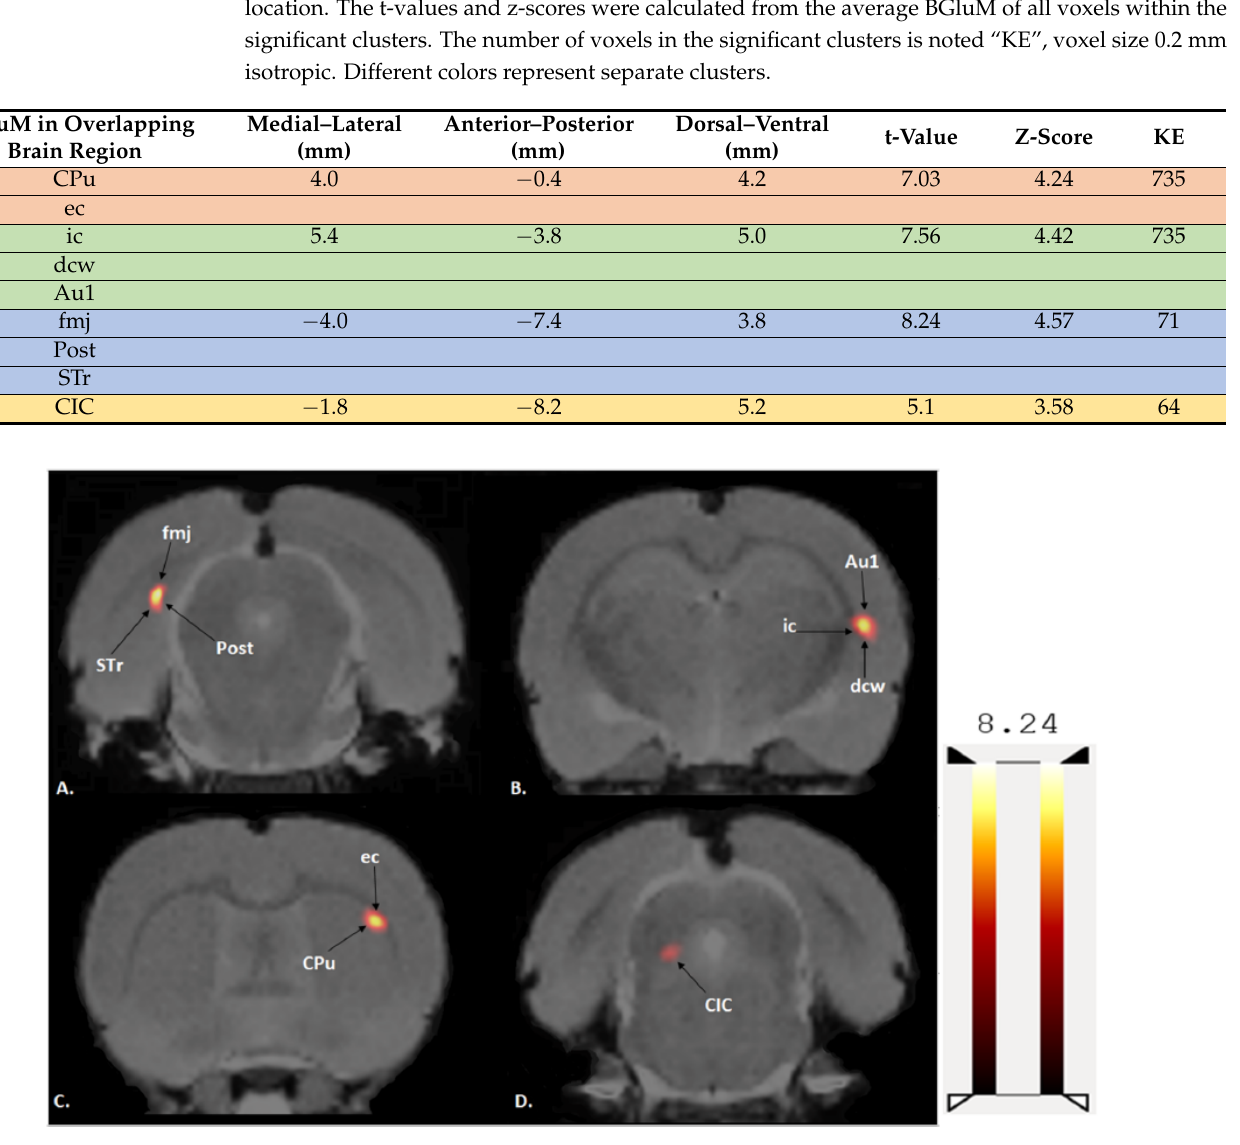
Figure 3. Coronal PET images showing brain regions with significant ( p < 0.001, df = 11, and K > 50) differences in brain glucose metabolism (BGluM) between exercised and sedentary rats. Hot scale clusters illustrate BGluM activation. The value 8.24 represents peak activation level, as expressed by the t-value: ( A ) fmj, Post, Subiculum, and STr; ( B ) ic, dcw, and Au1; ( C ) CPu and ec; and ( D ) CIC.